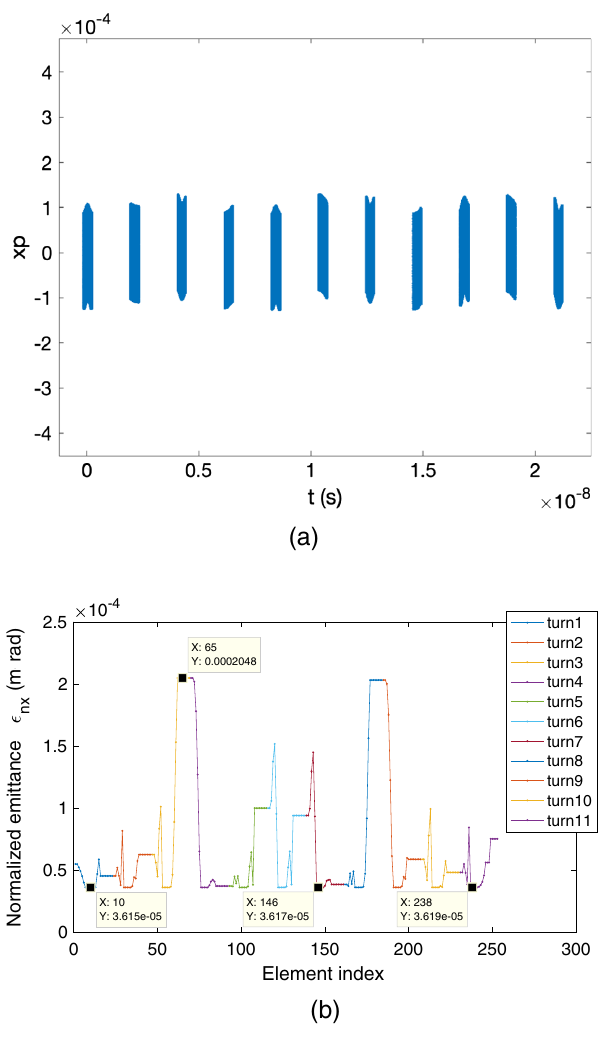
FIG. 10. The angular distribution evolution over the turns with multipoles in cancellation scheme. (a) The angular distribution over 11 turns with cancellation scheme implemented at 55 MeV. (b) The emittance growth over 11 turns with E e ¼ 55 cancellation scheme implemented at E e ¼